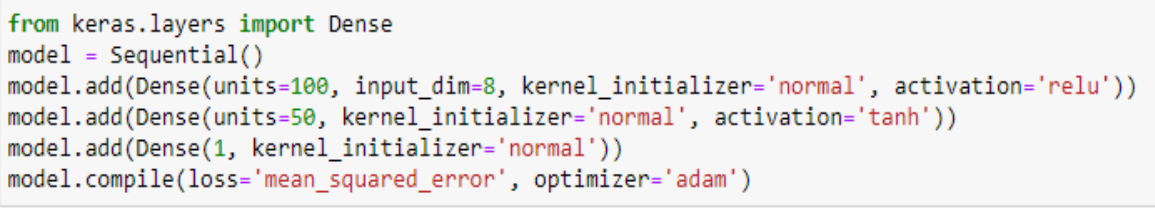
Figure 4. Selected parameters for the model.